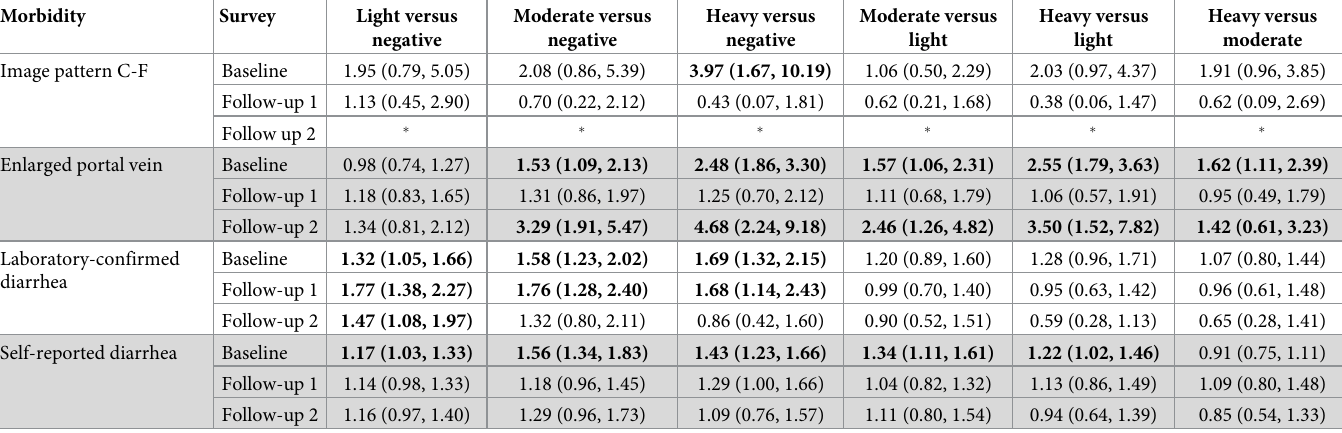
Table 4. Odds ratios (ORs) and 95% credible intervals from Bayesian logistic regression models comparing morbidity positive proportions between heavy-intensity prevalence categories within surveys for S . mansoni -related morbidities. Bold font indicates the 95% Bayesian credible interval does not contain one. Participants are school-age children (6–15 years), enrolled between 2003 and2008 in Mali, Niger, Tanzania, and Uganda.